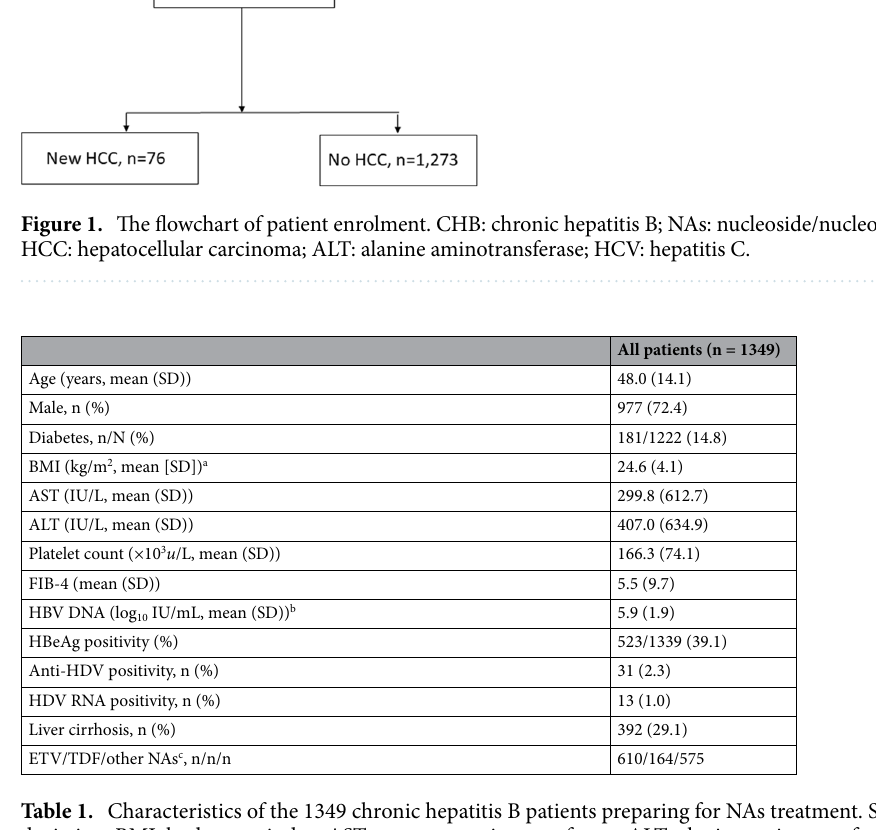
< 0.001) (Supplementary Table 2).